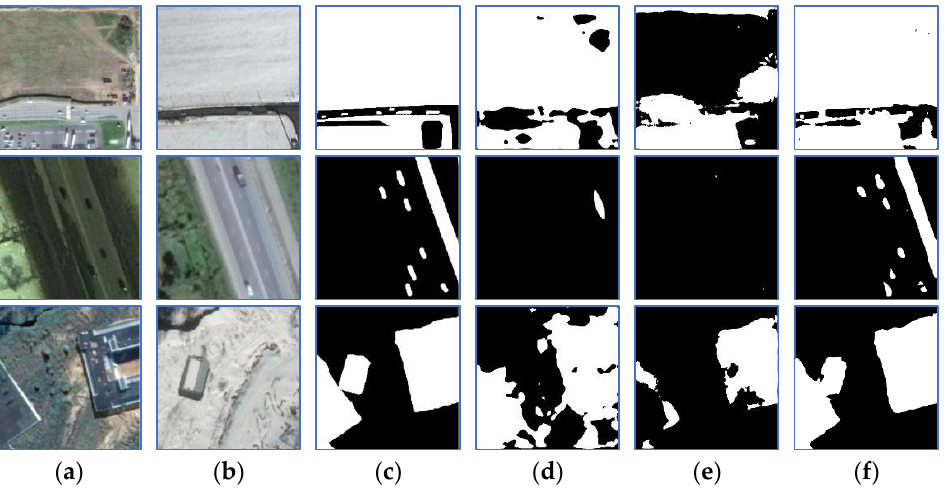
Figure 16. Change detection results on CDD: ( a ) image before the change, ( b ) image after the change, ( c ) ground truth, ( d ) detection results of SLN, ( e ) detection results of FC-Siam-diff, and ( f ) detection results of UNET-CD.